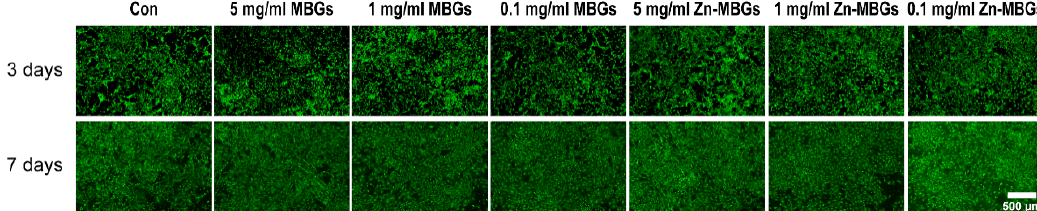
Figure 4. Live/dead staining of BMSCs incubated with MBGs and Zn-MBGs at different concentrations for three and seven days. Green staining represents living cells, while red staining represents dead cells.